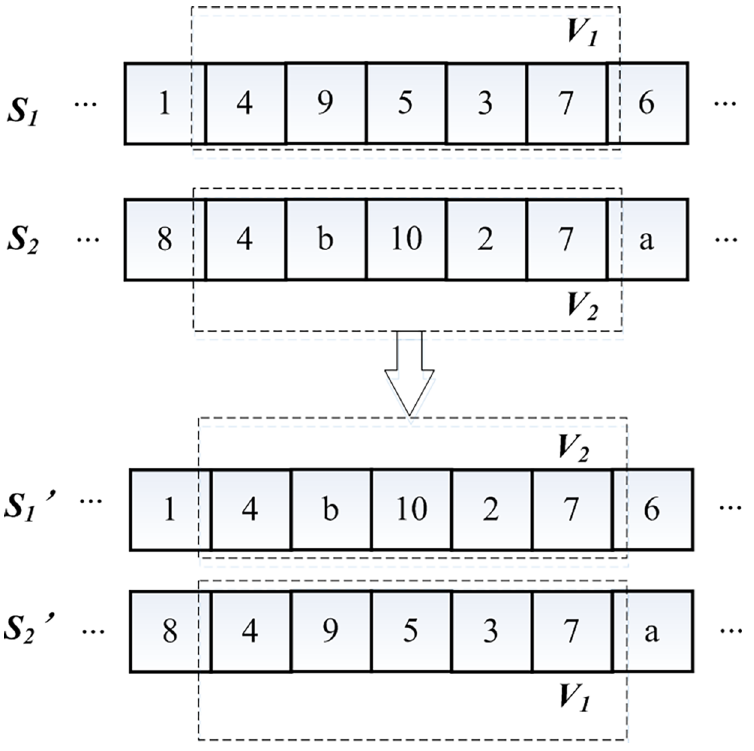
Fig 4. Schematic diagram of equal sub-segment crossover.